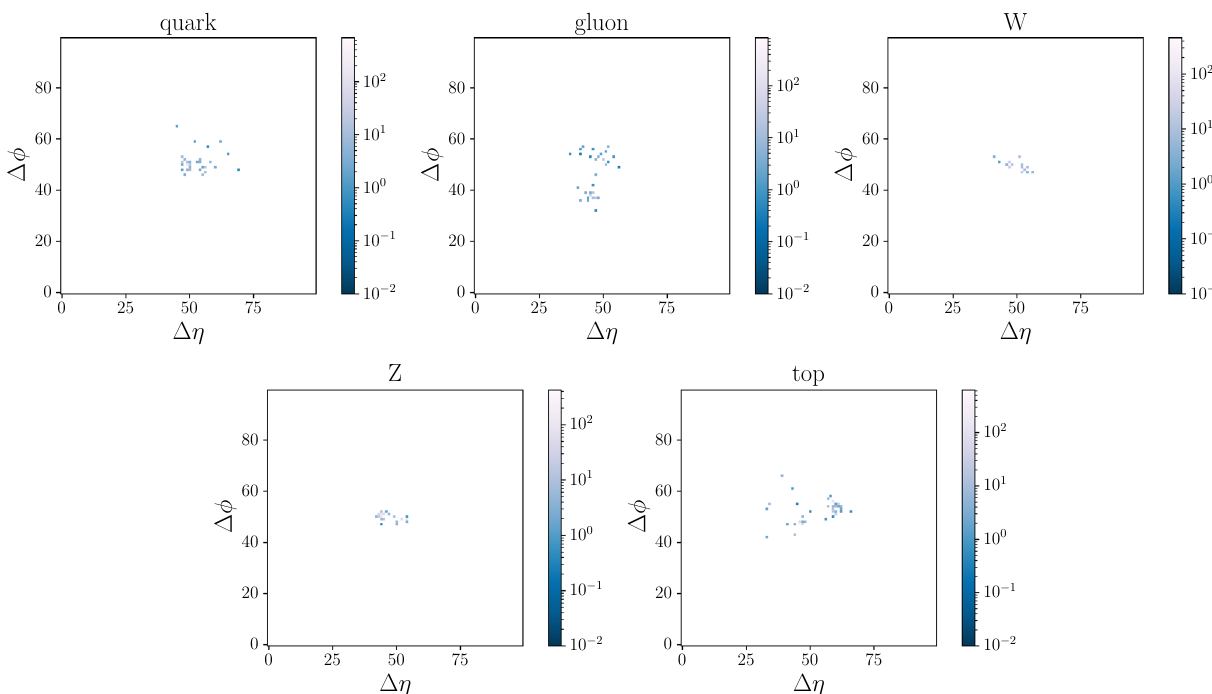
p T collected in each cell of the image, measured in GeV and computed from the scalar sum of the p T of the particles pointing to each